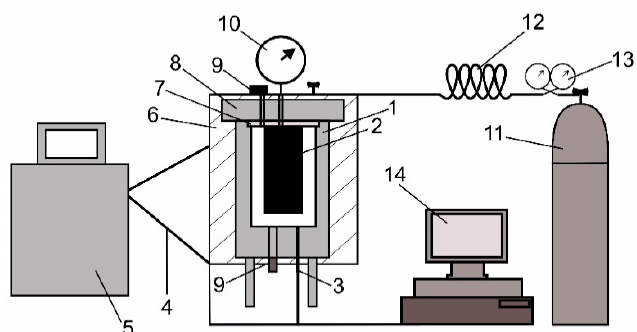
Figure 1. Sketch of experimental setup for modeling the dissociation of pore gas hydrates. 1 = pressure cell; 2 = container with soil samples; 3 = thermistor input sleeve; 4 = hose for circulating liquid; 5 = refrigerated bath; 6 = thermal coat; 7 = tephlon gasket; 8 = steel lid; 9 = pressure sensors; 10 = digital pressure gauge; 11 = gas bomb; 12 = gas tube; 13 = pressure regulator; 14 = PC with ADC.